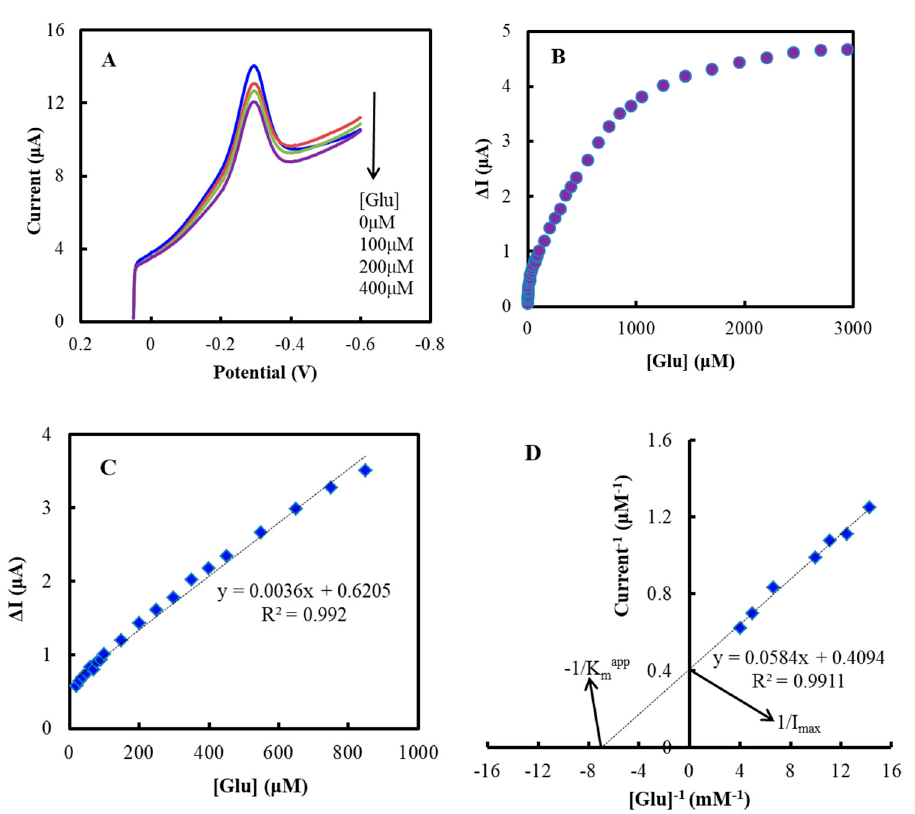
Figure 4. ( A ) Linear sweep voltammograms (LSVs) of the NF/GluOx/IL/mPEG-fMWCNTs modified GCE after air bubbling for 30 min at an air flow of 300 mL/min, in the absence and presence of different concentrations of glucose (0, 0.1, 0.2, 0.4 mM, respectively). ( B ) Plot of response current ( △ I ) versus concentration of glucose ([Glu]). ( C ) Linear range from 20 to 950 μ M. ( D ) Lineweaver-Burk plot for K mapp determination. The experiments were carried out in PBS (50 mM, pH 7.0) at a potential of − 0.30 V versus Ag/AgCl.